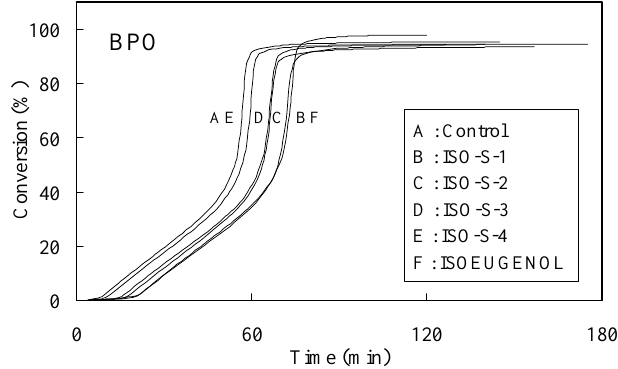
Figure 2 . Time-conversion curves for the polymerization of MMA initiated by thermal decomposition of BPO in the presence of 0.01 mol% additives. Curves were obtained from findings shown in Figure